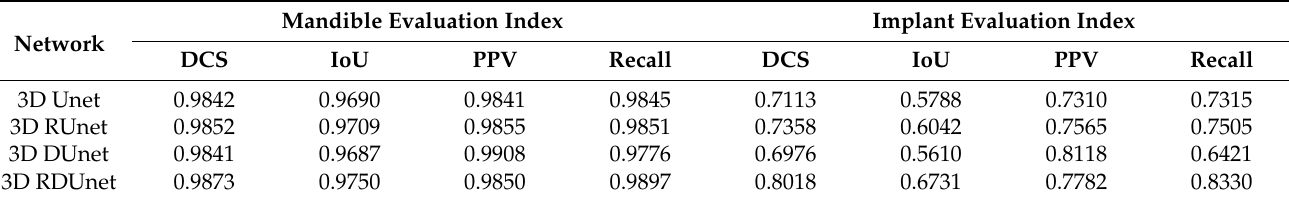
Table 2. Evaluation index.